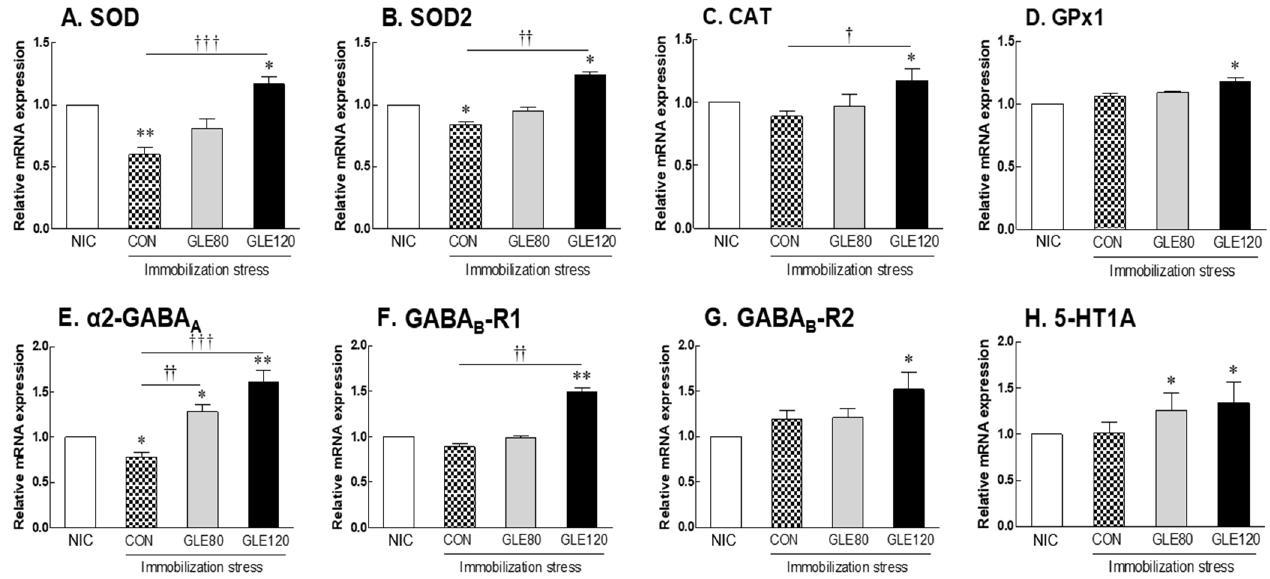
Figure 5. Effects of GLE (green lettuce leaf extract) on ( A ) SOD, ( B ) SOD2, ( C ) CAT, ( D ) GPx1, ( E ) α 2 -GABA A , ( F ) GABA B -R1, ( G ) GABA B -R2, and ( H ) 5-HT1A mRNA expression by immobilization stress in rats. Brain tissue was collected nine days after oral administration. Experimental groups include the no-immobilization-stress control group (NIC), control group (CON, stress-induced immobilization), and GLE (green lettuce leaf extract)-treated groups with stress (80 and 120 mg/kg). Values are presented as the mean ± standard error of the mean (SEM) for each group, n = 8. * p < 0.05 and ** p < 0.01 when compared with the NIC group. † p < 0.05, †† p < 0.01, and ††† p < 0.001 when compared with the CON group (ANOVA followed by post-hoc Tukey’s test). α 2 -GABA A : GABA A receptor subunit